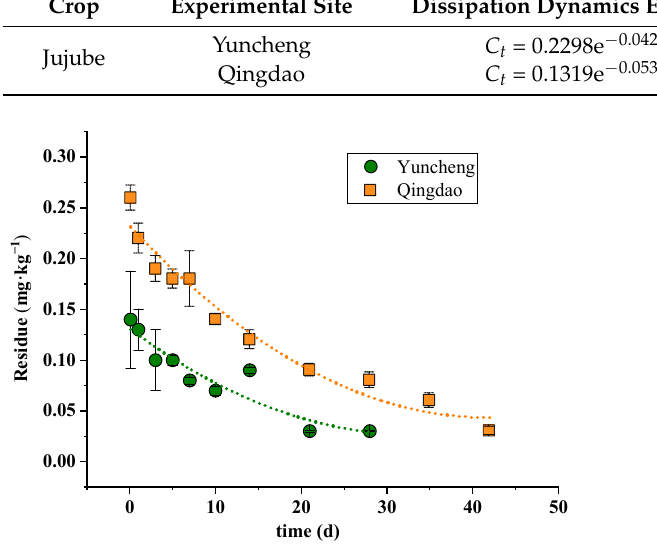
Table 2. Dissipation kinetic parameters of difenoconazole on jujube. Crop Experimental Site